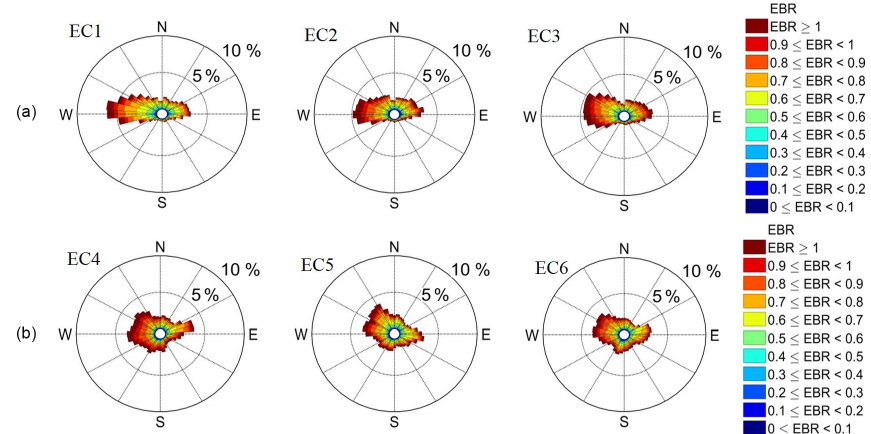
Figure 8. Distribution of half-hourly energy balance ratios (EBR) in terms of wind direction at eddy-covariance (EC) stations during the 2010–2017 study period. Spike lengths in diagram show relative frequency of wind directions; color of legend shows EBR. This is shown for (a) Kraichgau and (b) Swabian Jura.